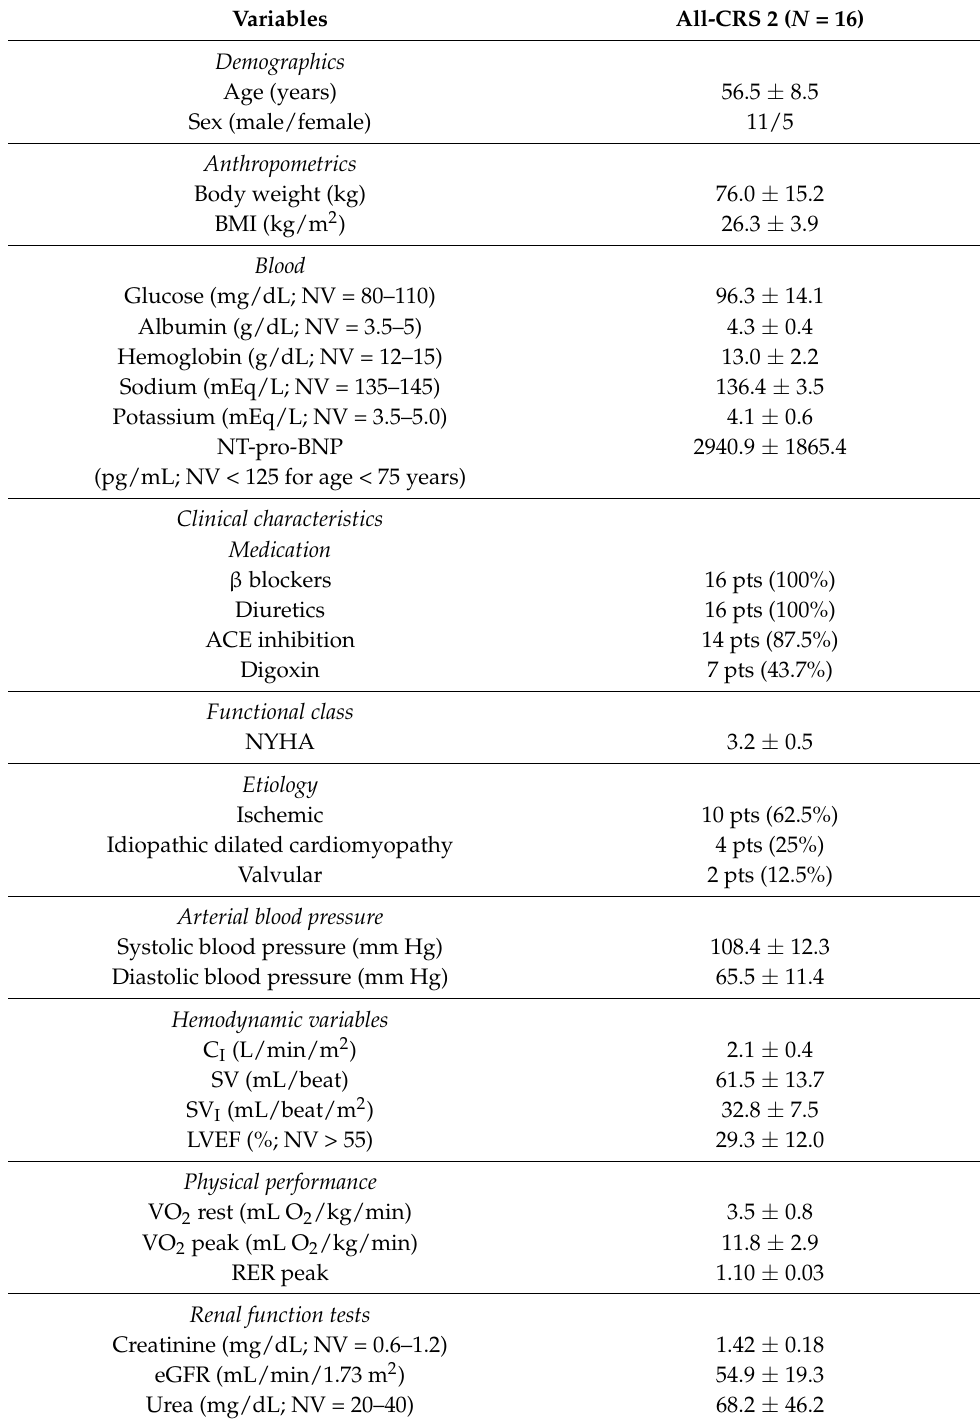
Table 1. Demographic, anthropometric and clinical characteristics, functional class, etiology, biohu- moral variables, cardiac hemodynamic variables and renal function tests of the studied cardiorenal syndrome type 2 (CRS 2)